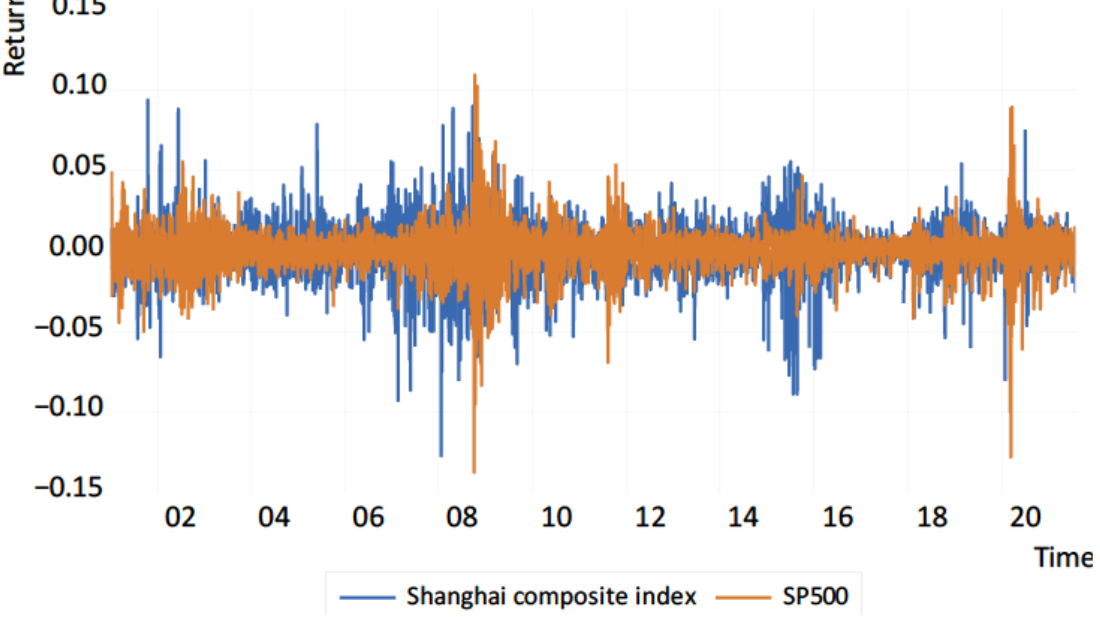
Figure 1. Log returns of SHCI and SP500 from January 2001 to July 2021.